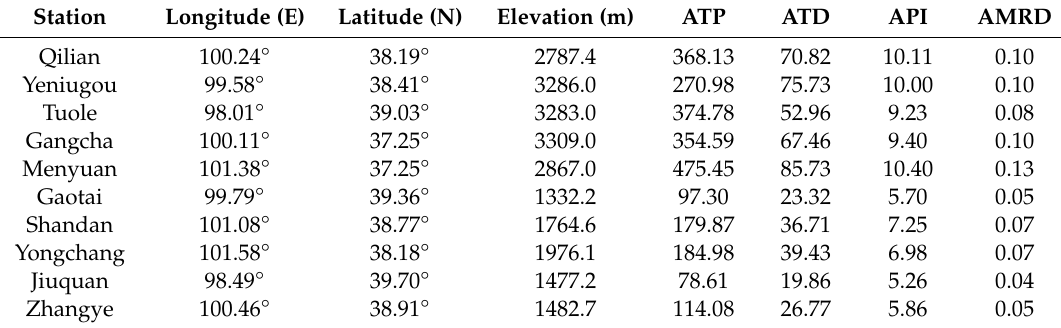
NB: the definitions of abbreviations are shown in Table 3.